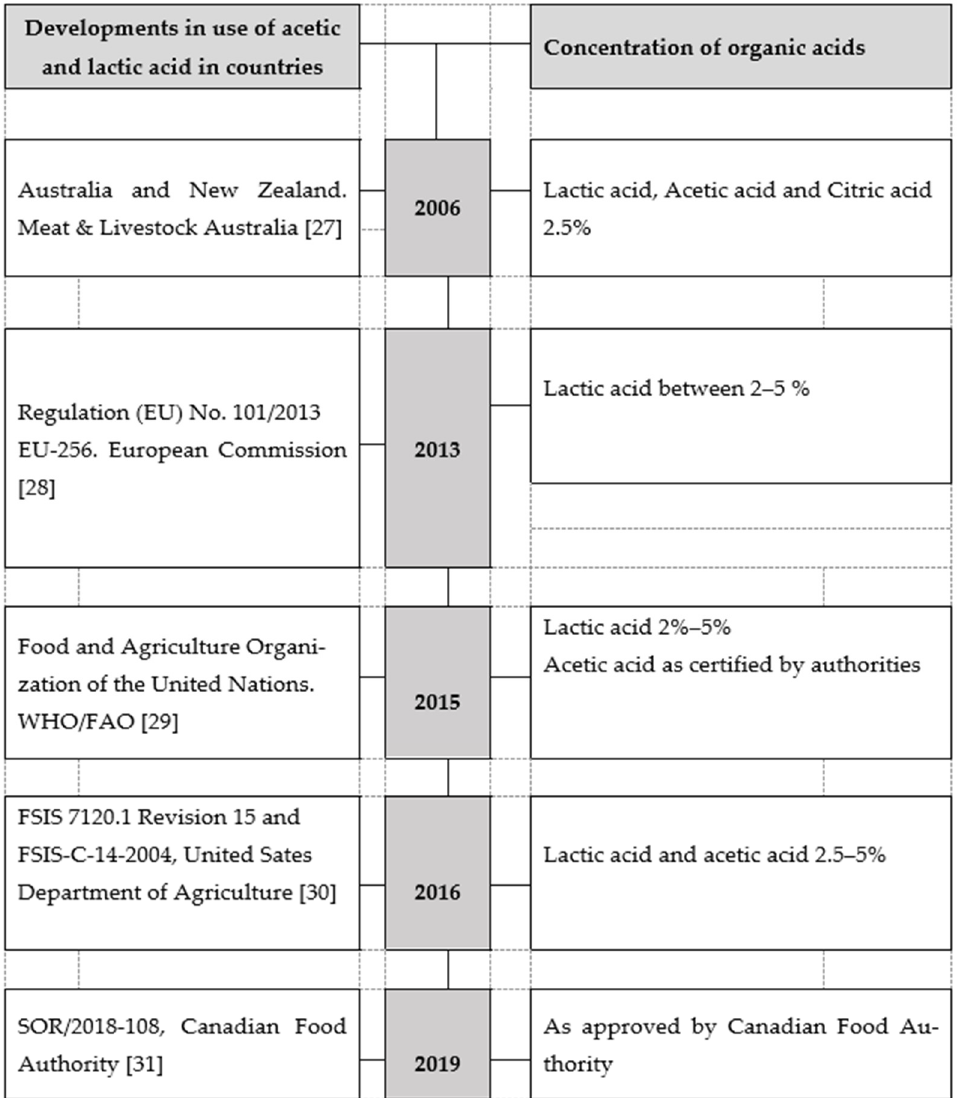
Figure 2. Regulations and guidelines on the use of acetic and lactic acid to decontaminate carcasses globally. Note: The legislation and guidelines, or standards are from the inception of any relevant legislation. Existing and current regulations or guidelines are included from the date they became applicable or date of release. Some of the countries started developing these guidelines as early as 2006.